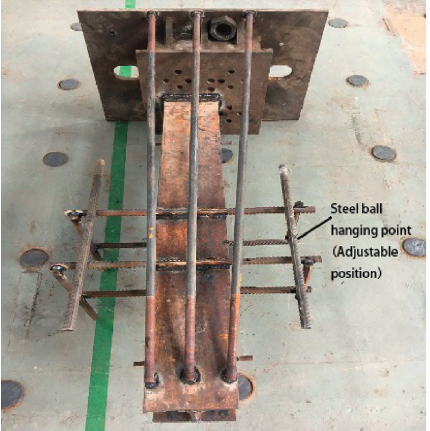
Figure 9: Support beam.